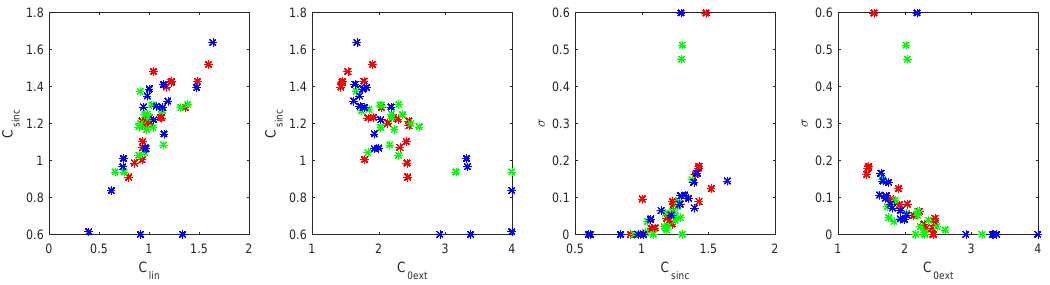
Figure 9. Interdependencies of the model parameters. Red marks denote pine, green spruce and blue deciduous